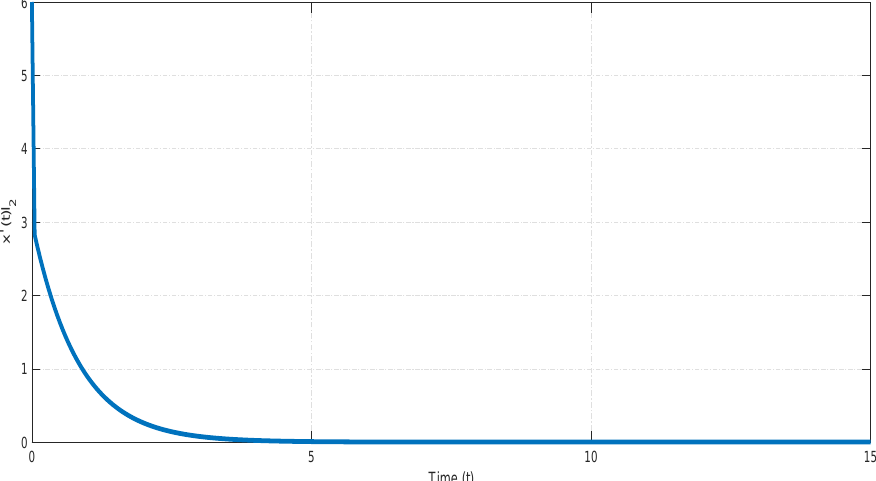
Figure 2. The value of x T ( t ) l 2 of the second subsystem in Example